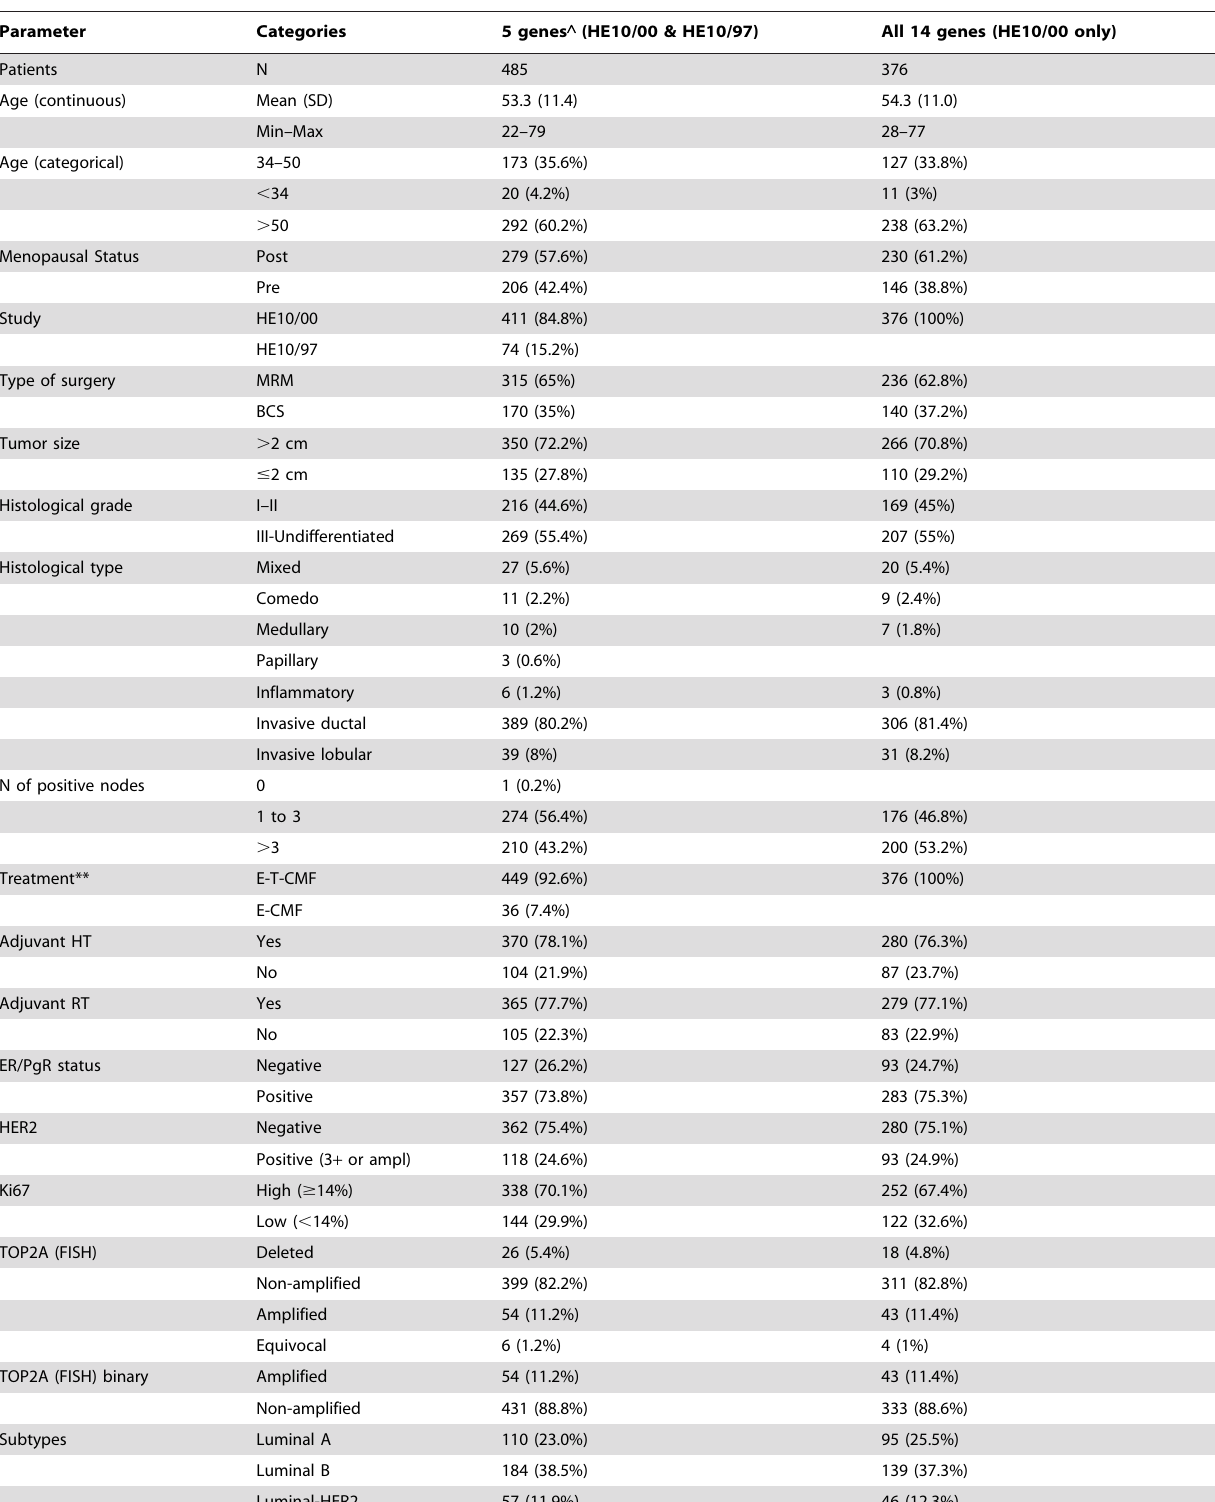
Table 1. Demographic and clinicopathological characteristics of patients and tumors from HE10/00 & HE10/97